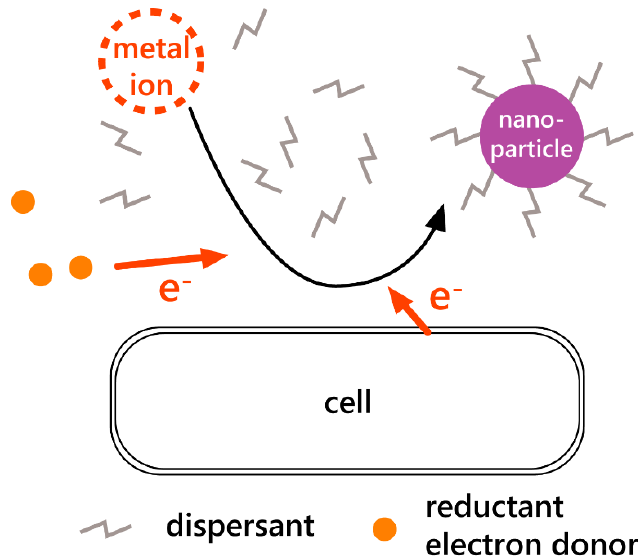
Figure 2. Model of metal nanoparticle synthesis outside cells. Metal ions are reduced by an added electron donor or reductant secreted from the cells. The secreted metabolites outside the cells surround the surface of the NPs and behave as dispersants.